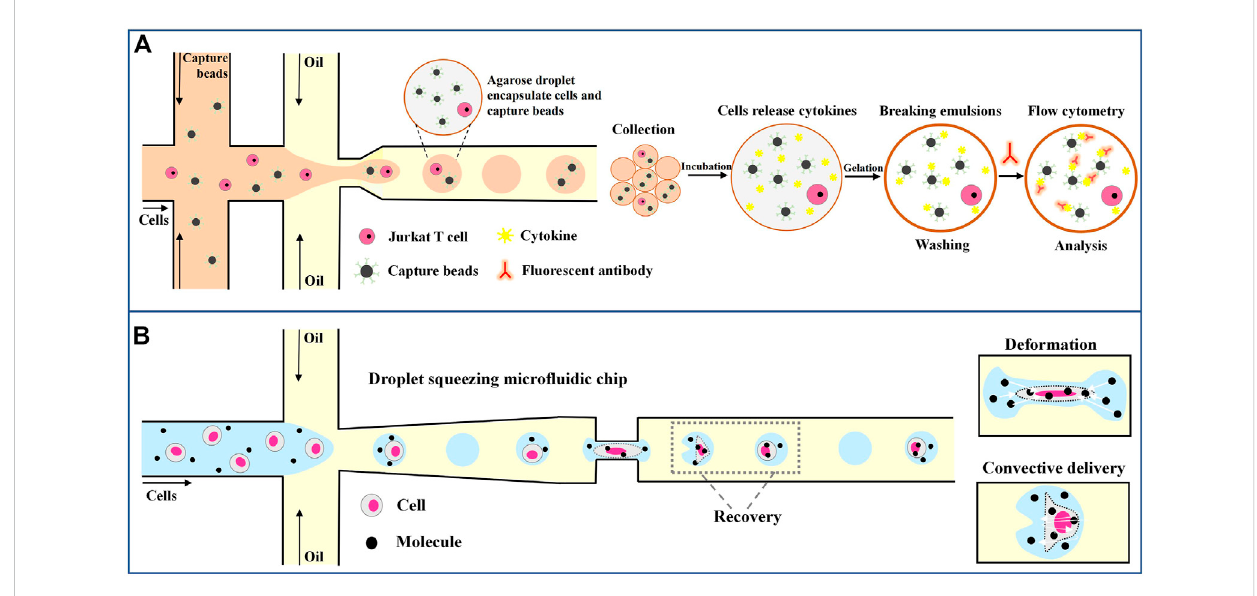
FIGURE 8 Droplet micro fl uidics for single-tumor-cell immunoassay. (A) Schematic overview of the work fl ow of the droplet-based micro fl uidic method for single-cell encapsulation and detection of secreted cytokines (Chokkalingam et al., 2013). (B) Molecules and cells are encapsulated in the droplet, and ef fi cient transfection is achieved through deformation recovery when passing through a narrow micro fl uidic channel (Joo et al.,